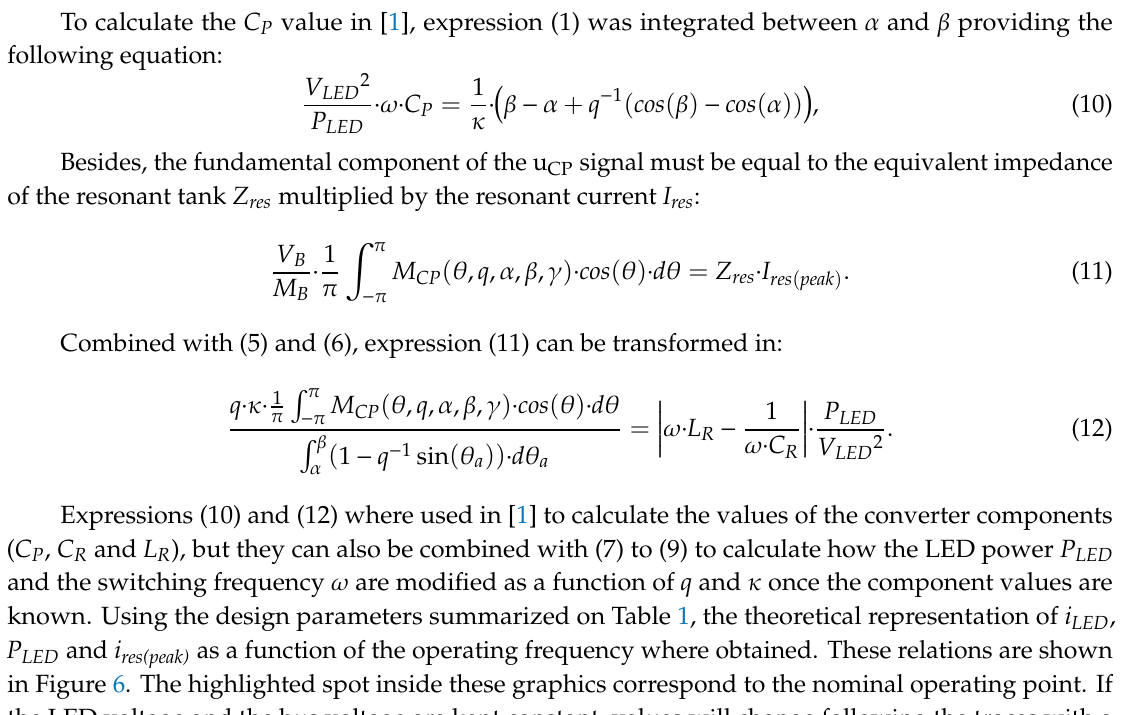
Figure 5. Theoretical waveforms for  equal to 2.